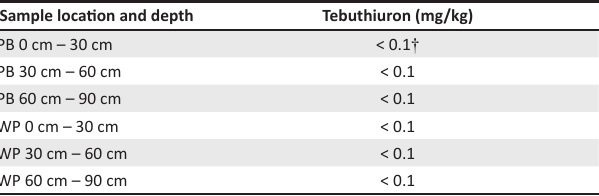
TABLE 2: Tebuthiuron presence in soil samples from different depths at Puntberg and Windpomp sites in Mokala National Park. (Minimum detection level was set at 0.1